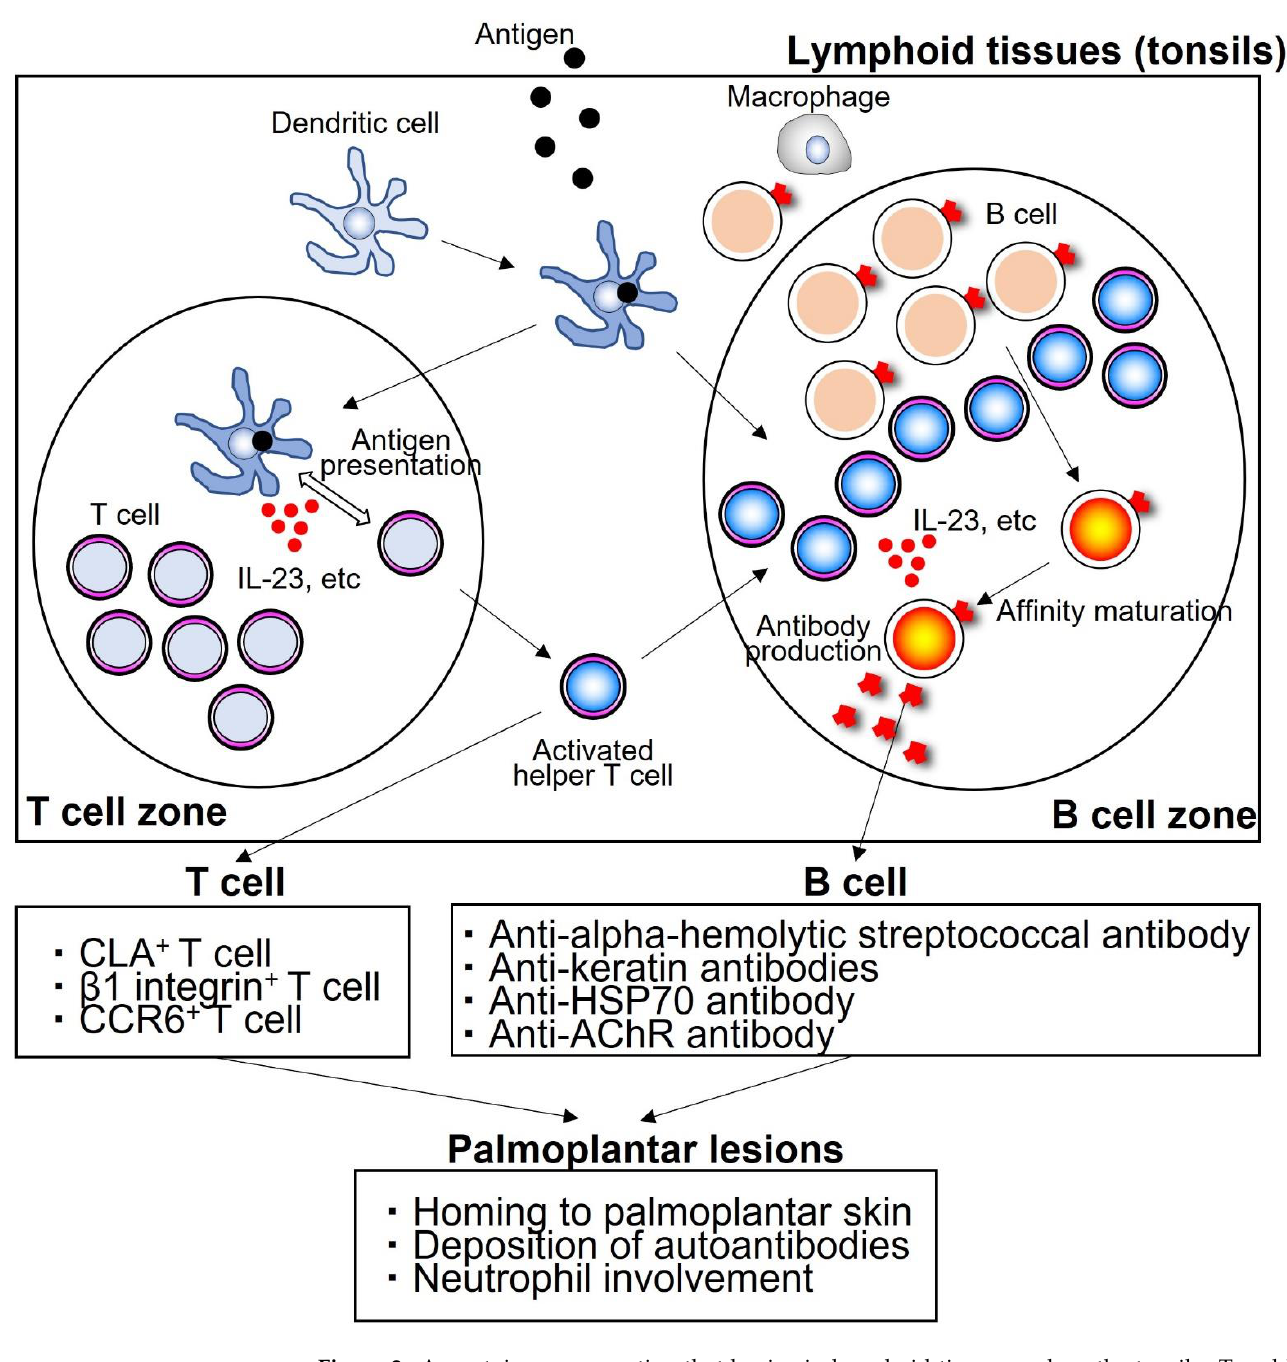
Figure 2. An autoimmune reaction that begins in lymphoid tissues such as the tonsils. T and B cells are activated in lymphoid tissues by cytokines such as IL-23. Activated T cells homing to the lesions on the palmoplantar surface. Activated B cells produce autoantibodies. CLA: cutaneous lymphocyte-associated antigen, CCR: C - C chemokine receptor , HSP: heat shock protein, AChR: acetylcholine receptor.